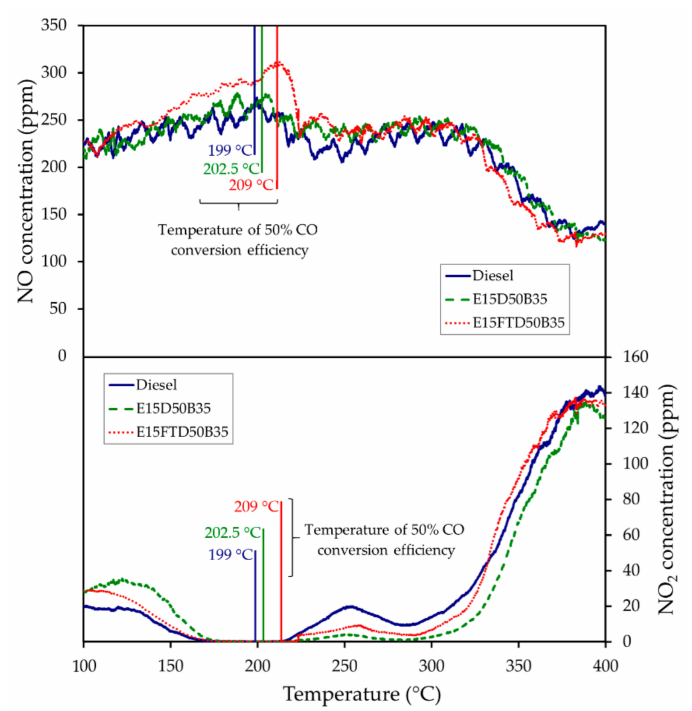
Figure 10. NO and NO 2 downstream DOC catalyst at 2 bar IMEP and 1500